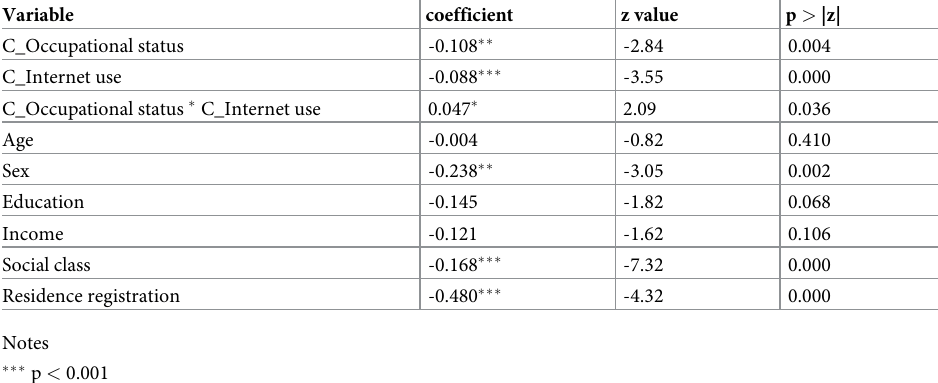
Table 6. Results of robustness test (N =